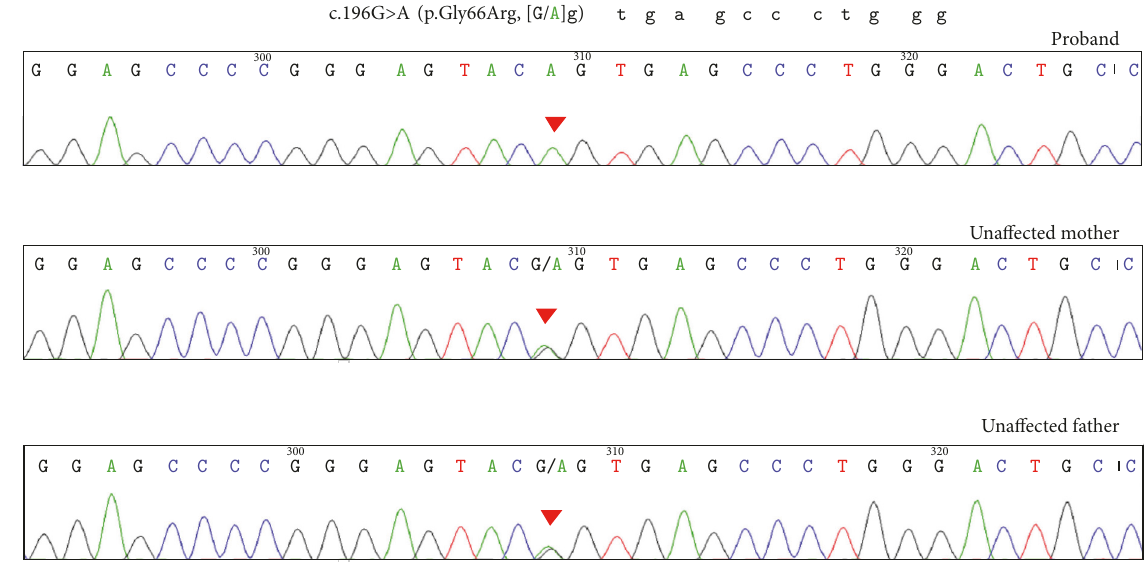
Figure 1: Electropherogram of the proband and his parents.